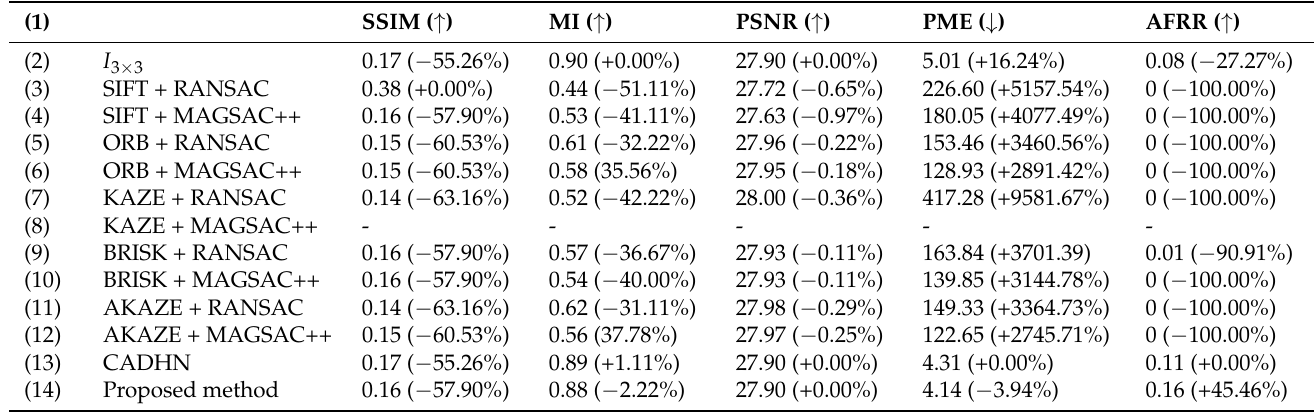
Table 5. Quantitative comparison on real